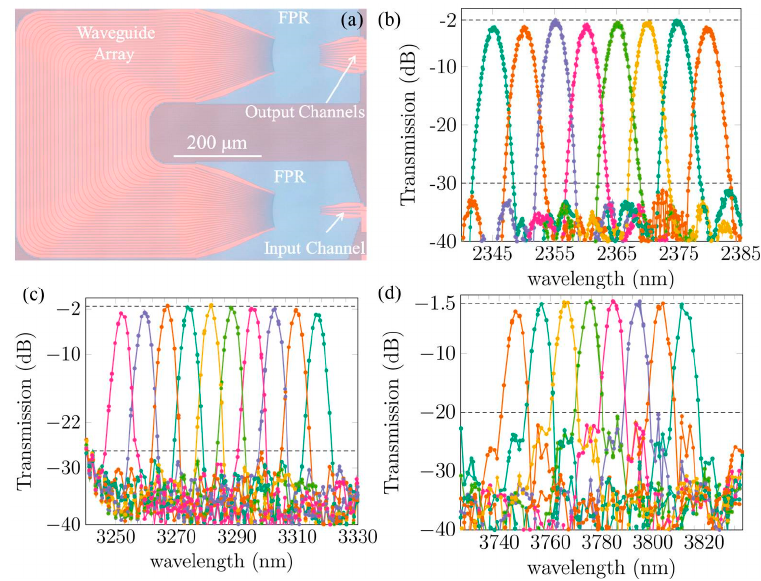
Figure 12. ( a ) Microscope image of a 2.3 μ m silicon arrayed waveguide grating (AWG) spectrometer; the measured spectral responses of all the channels in three AWGs operating at different wavelengths: ( b ) 2.3 μ m; ( c ) 3.3 μ m and ( d ) 3.8 μ m.